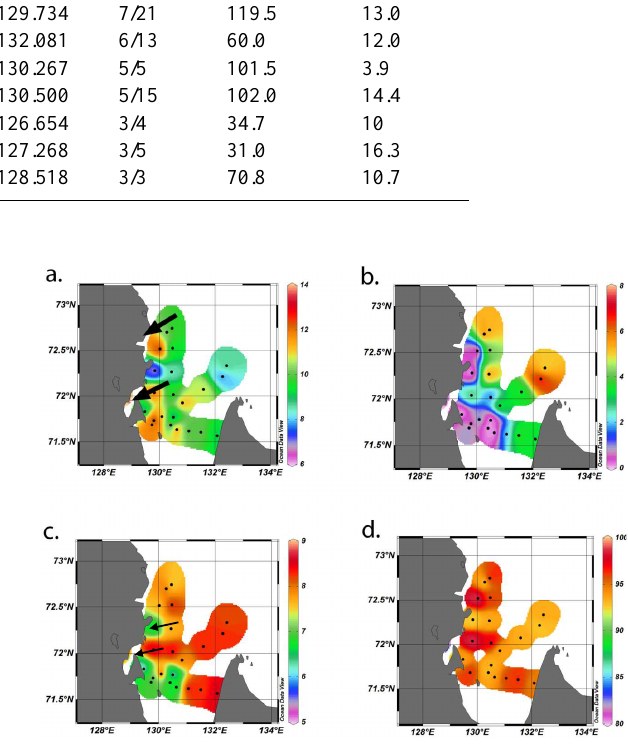
Fig. 2. ODV surface plots for (a) temperature ( ◦ C), (b) salinity, (c) pH, and (d) oxygen (%) for the area covered by the 4 coastal tran- sects, as obtained from CTD